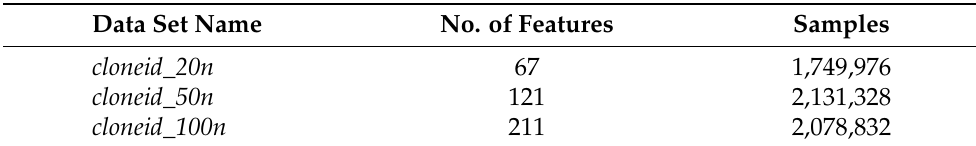
Table 7. Data set descriptions after the pre-processing steps.